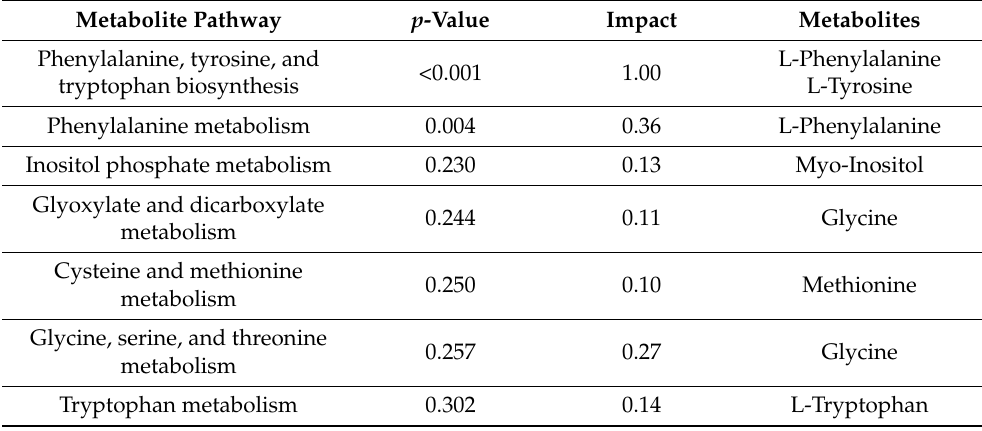
Figure 4. Metabolic pathway map related to metabolic profiling in serum, according to the effects of heat stress in the LTLH and HTHH groups. Table 8. List of potential metabolic pathways that change in serum, according to heat